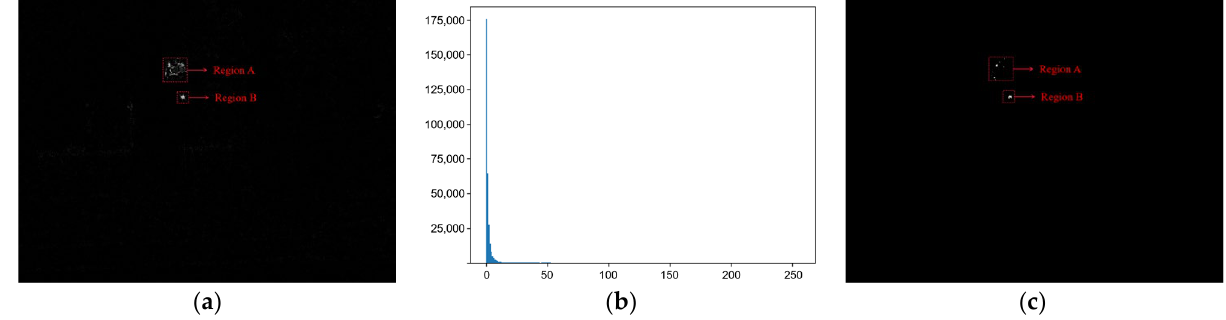
Figure 6. Histogram statistics in outdoor environment: ( a ) differential image containing the photoelectric target, ( b ) histogram of the differential image, and ( c ) image containing the segmentation of the photoelectric target threshold.